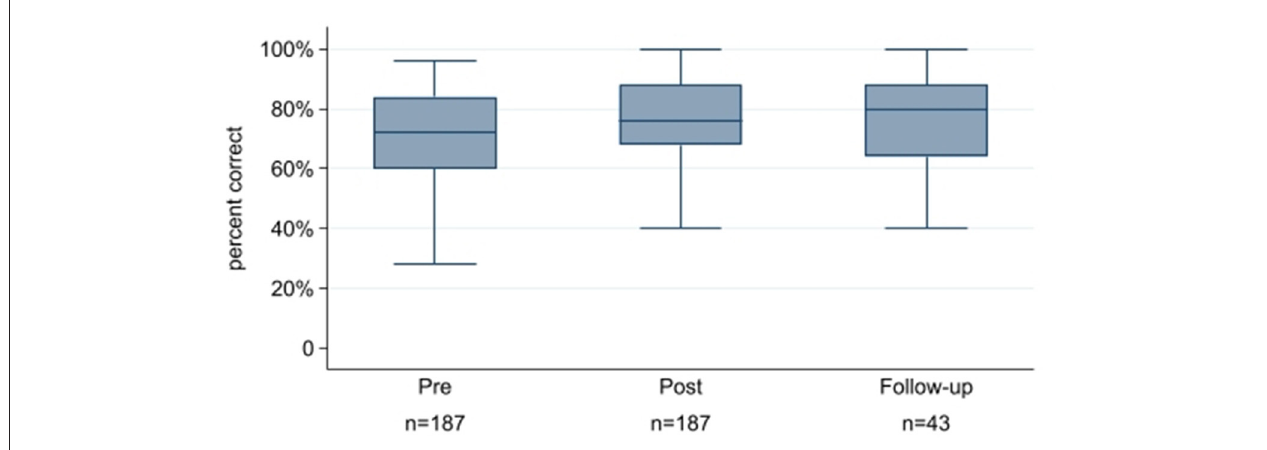
FIGURE 2 | Knowledge change and retention at 6 month follow-up. Box plots represent scores on the knowledge assessment at the pre-training, post-training, and follow-up intervals. The lines are the median scores, the boxes are the 25th and 75th percentiles, and the whiskers are the upper and lower adjacent